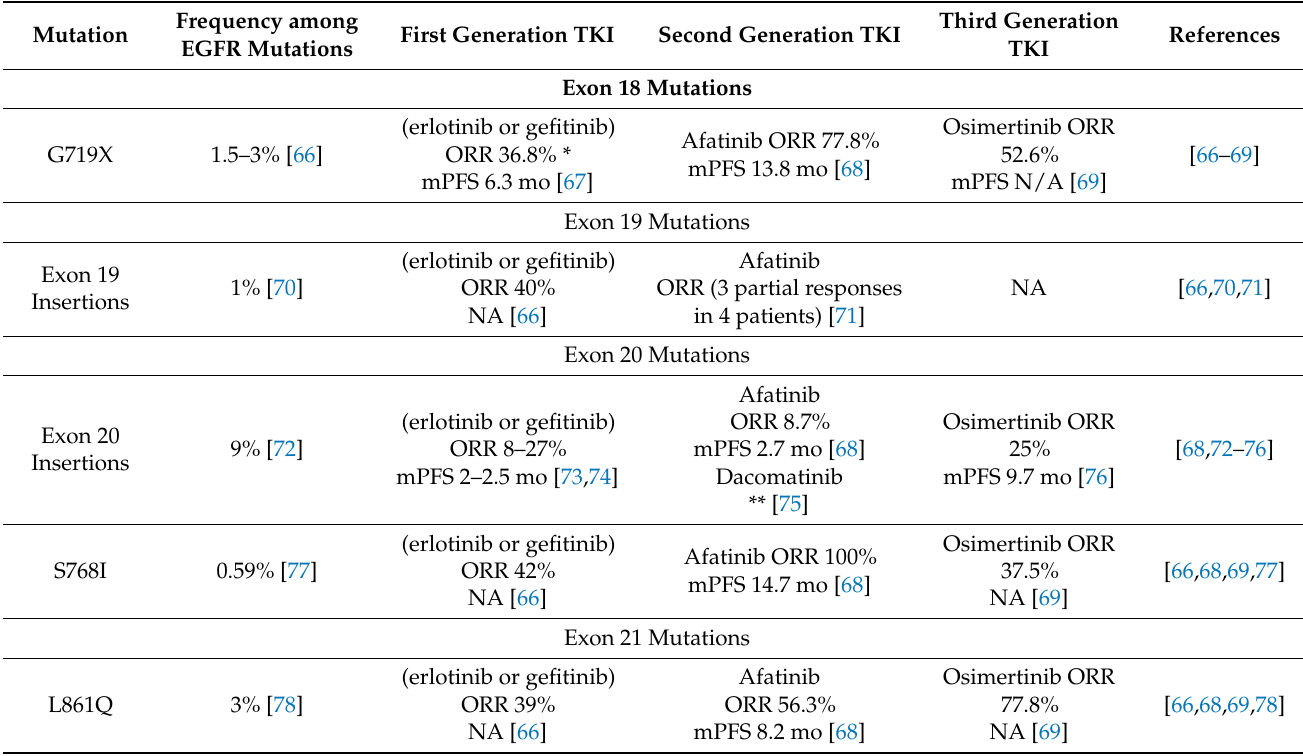
Table 2. Efficacy of select studies with approved EGFR TKIs in lung cancer with uncommon EGFR mutations.